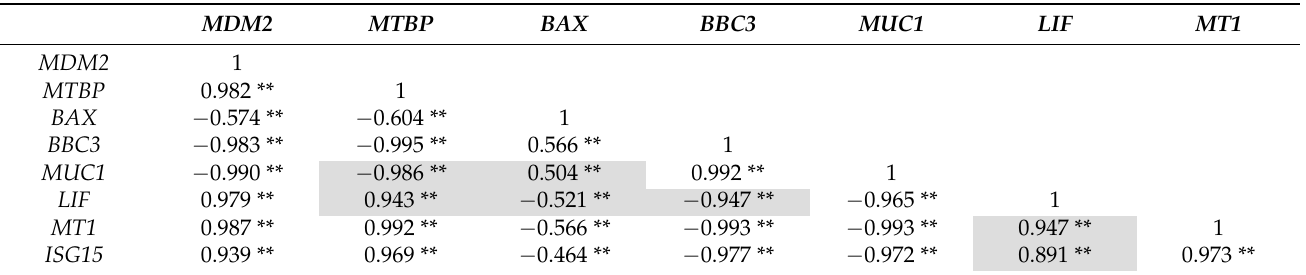
Table 1. Simple correlations of genes expressed in uterine luminal cells collected at day 16 after insemination from pregnant, pregnant with embryo loss, and nonpregnant lactating dairy cows.